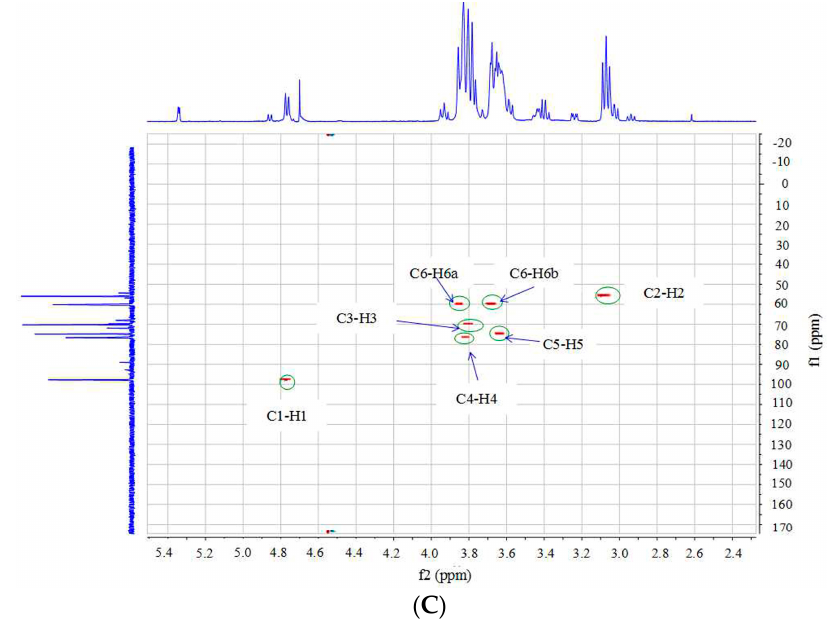
Figure 4. Two-dimensional nuclear magnetic resonance spectra of oligochitosan DP5: 1 H- 1 H COSY ( A ); ROESY ( B ); and 1 H- 13 C HSQC ( C ). Correlation peaks are marked on the spectra. COSY, correlation spectroscopy; ROESY, rotating frame nuclear Overhauser effect spectroscopy (NOESY); HSQC, heteronuclear single-quantum correlation spectroscopy.